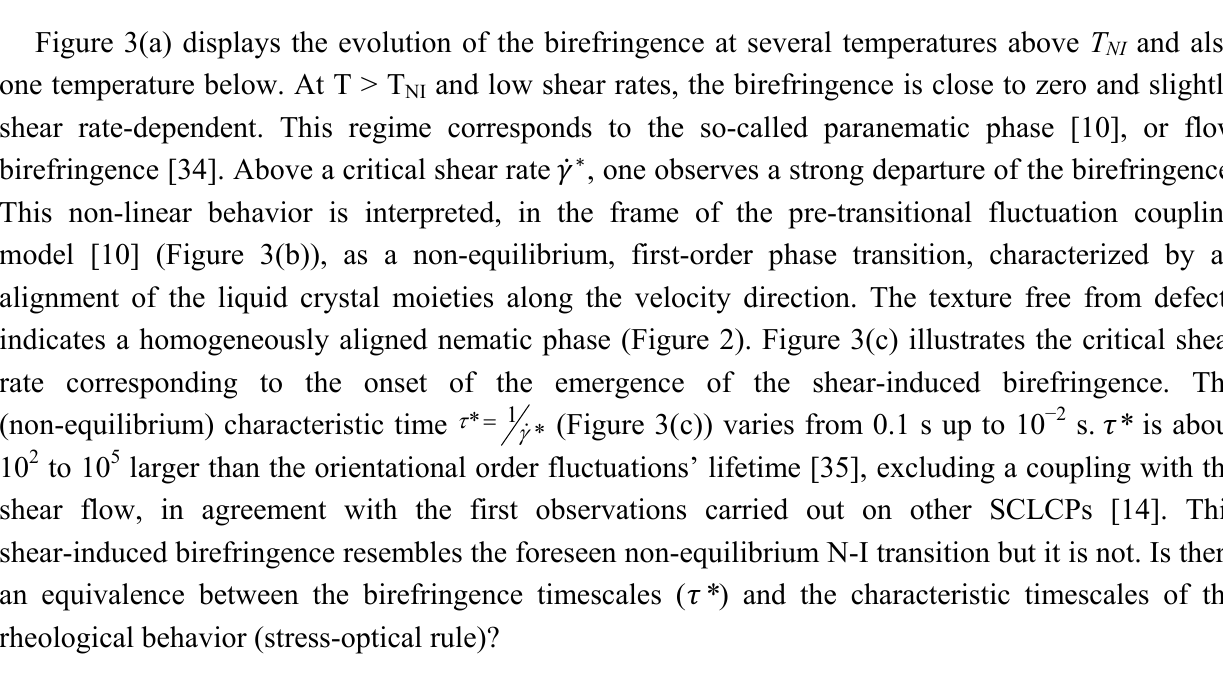
Figure 3. ( a ) Evolution of the birefringence Δ n of PANO2, measured in the (velocity, neutral axis) plane at 0.060 mm gap thickness as a function of the shear rate (  (cid:4662) ) at different : T-T : − 2 °C( ○ ), +1 °C( ■ ), +3 °C( □ ), +5 °C( ♦ ), +10 °C( Δ ). The temperatures away from T NI NI